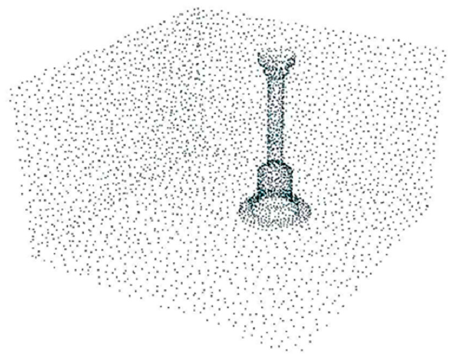
Figure 4. Artificial cloud setup.